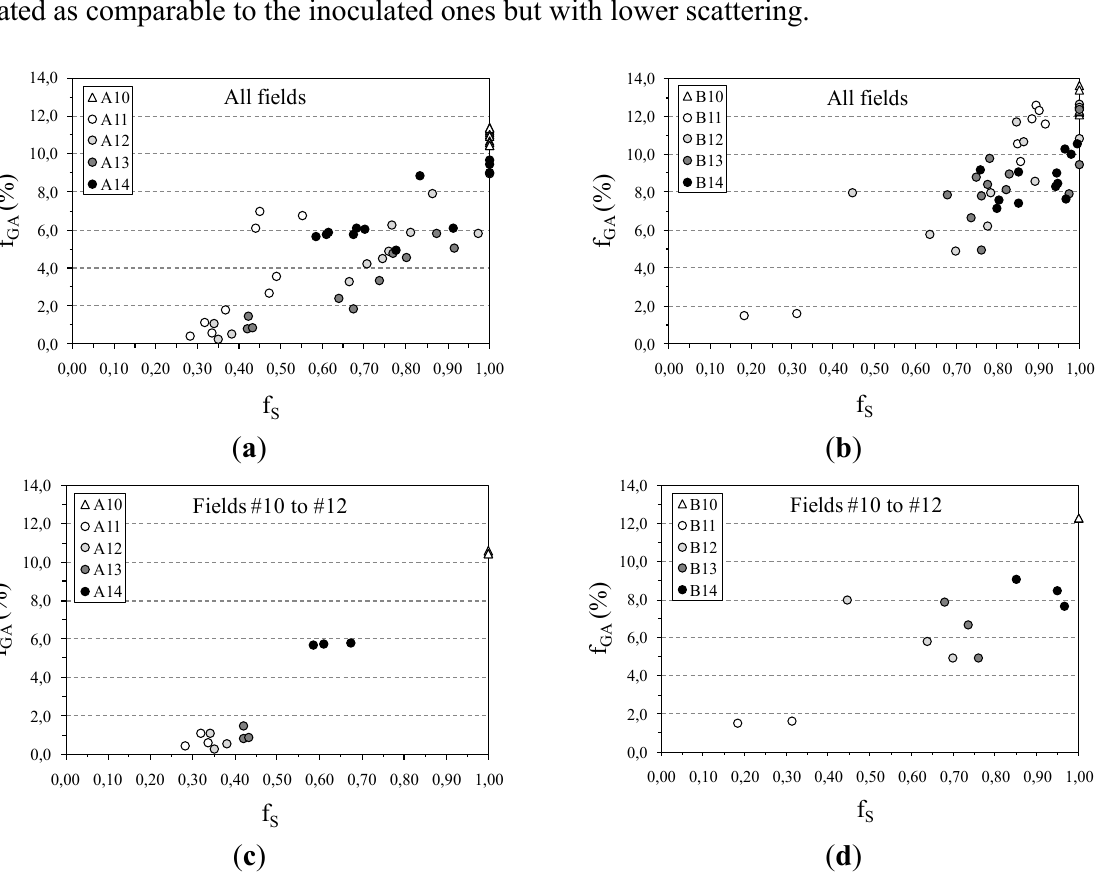
Figure 8. f S vs. f GA correlations for the two inoculated cast irons. ( a ) all fields for A1 series; ( b ) all fields for B1 series; ( c ) Fields #10 to #12 for A1 series; ( d ) Fields #10 to #12 for B1